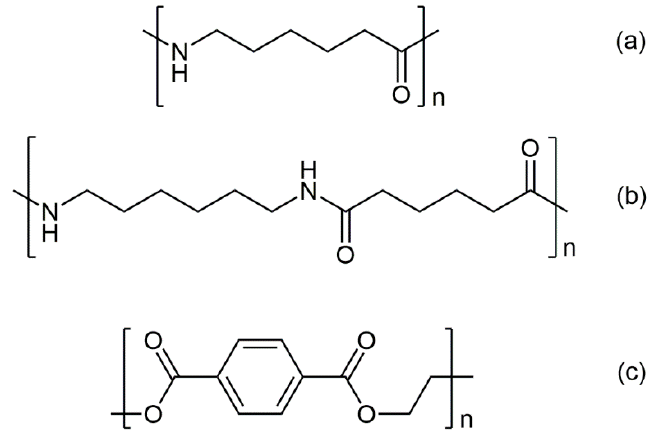
Figure 4. Polymer repeating units: ( a ) nylon 6 (polycaprolactame, the homopolymer of AHA); ( b ) nylon 6,6 (copolymer of adipic acid and HMDA); ( c ) PET (polyethylene terephthalate).